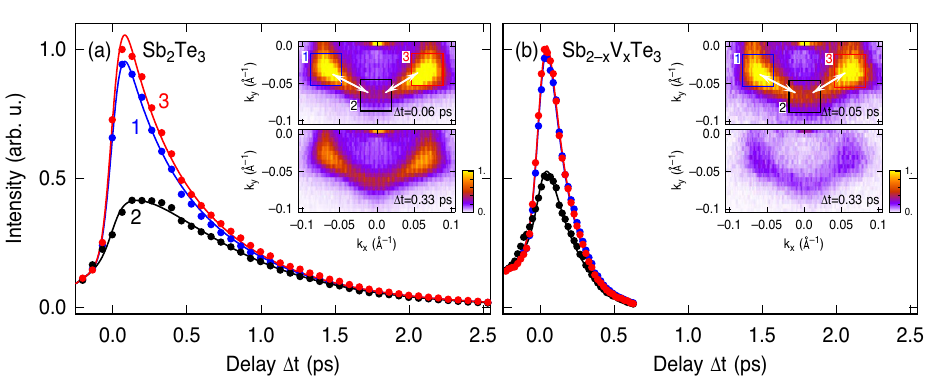
Figure 4. Comparison of the population dynamics between pristine ( a ) Sb 2 Te 3 and ( b ) Sb 2 − x V x Te 3 with x = 0.015 with the ¯ Ŵ – ¯ M direction aligned along the plane of incidence. The insets show k x – k y maps centered at E − E D = 140 meV for two selected time delays (cid:31) t . Data points show the intensity integrated over the blue and red square areas depicted in the k x – k y maps. Solid lines show fits to the